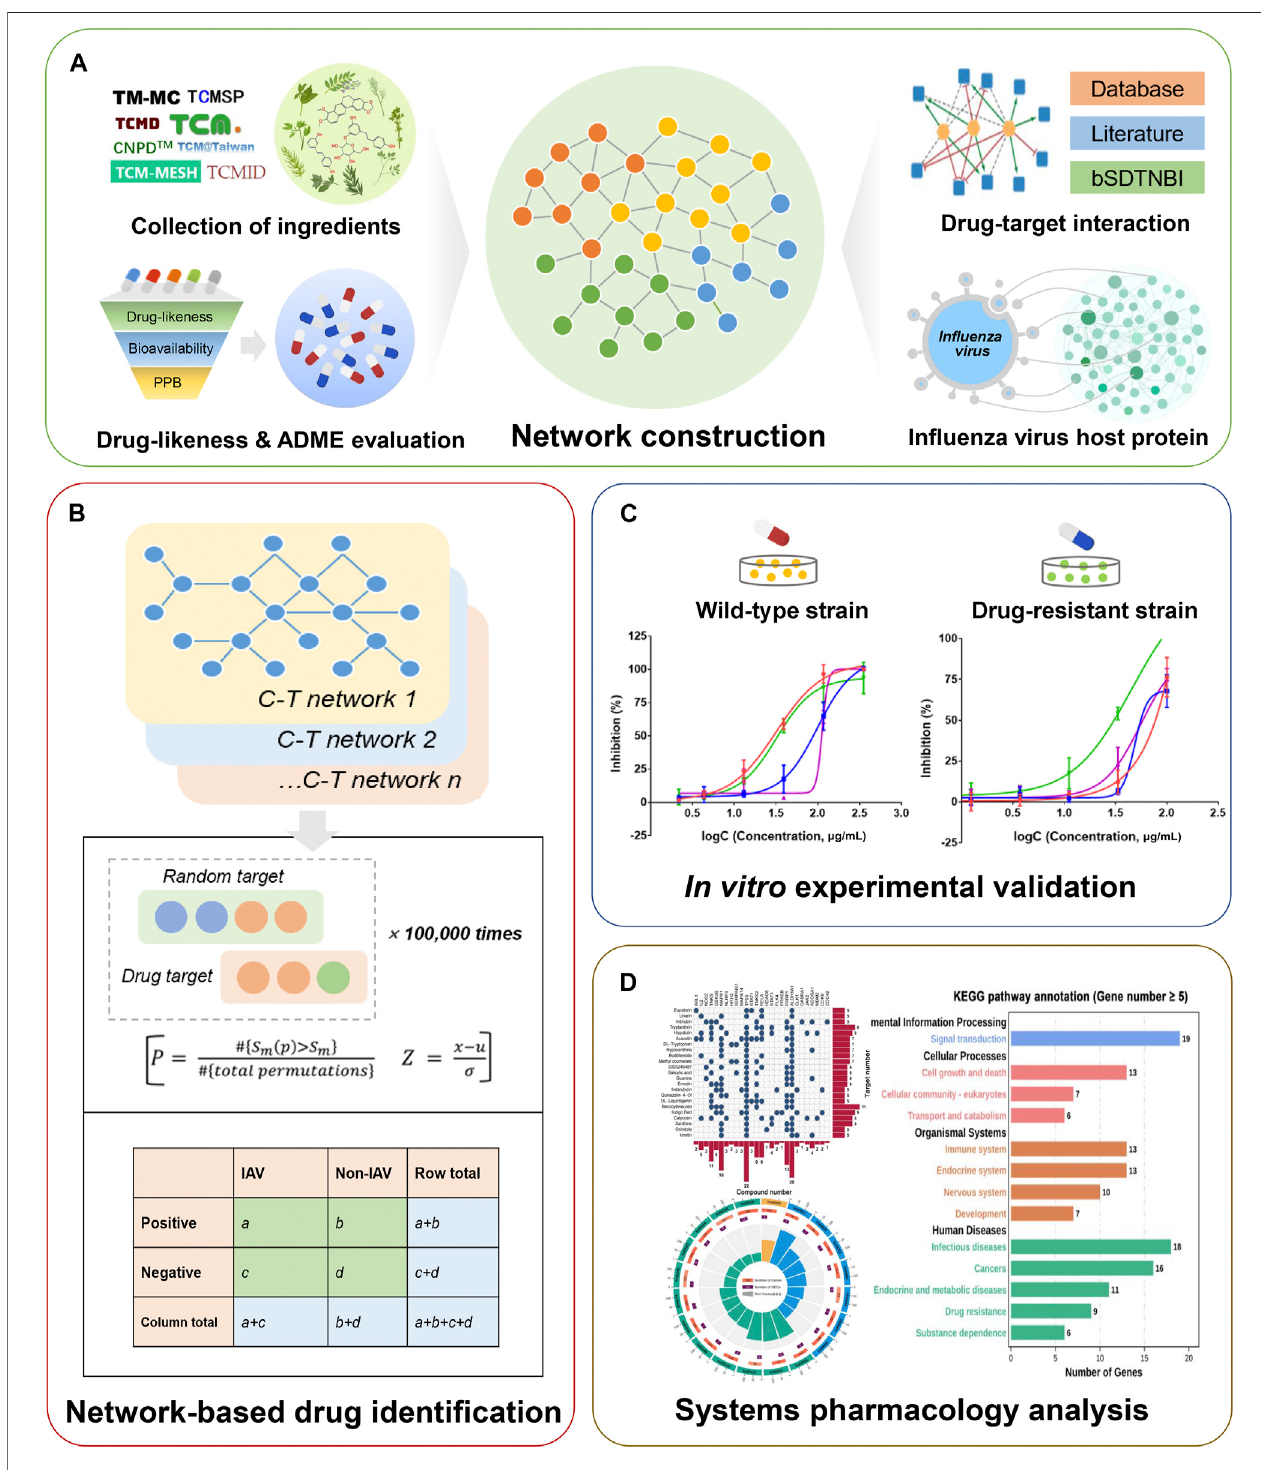
FIGURE 1 | Schematic diagram illustrating the network methodology for the in silico identi fi cation of drug candidates against in fl uenza A virus (IAV) from Isatis tinctoria L. (BLG). (A) Construction of the compound – target (C – T) networks of BLG. Ingredients screened by drug-likeness and ADME (absorption, distribution, metabolism, and excretion) evaluation, multi-source drug – target interactions, and in fl uenza virus host proteins were integrated into the C – T network. (B) In silico identi fi cation of IAV drug candidates using network-based predictive models. Associations between the subnetwork of compounds and the in fl uenza virus host proteinsetwerecalculated. (C) Invitro evaluationofpotentialanti-IAVcandidatesthroughcytopathiceffectreductionassayonwild-typeanddrug-resistantvirusstrains. (D) Systems pharmacology-based exploration of the anti-IAV mechanism of actions (MOAs) of BLG.